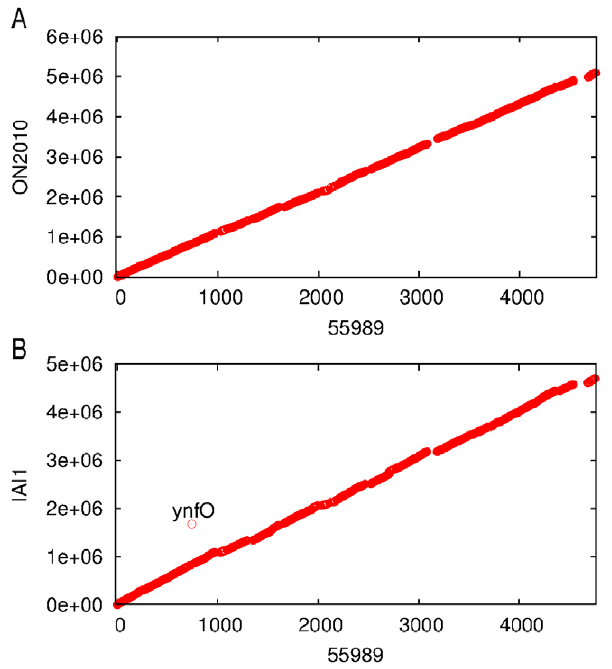
Figure 5. Genome synteny. (A) 55989 vs. ON2010; (B) 55989 vs. IAI1. Homologous matches are taken to have an expected value , 10 2 20 for all the 3792 genes shared by IAI1, 55989, 01-09591, ON2010 and ON2011 in a BLASTN search. The x-axis shows the order of genes on the 55989 chromosome. The y-axis shows the nucleotide coordinates of the subject genome.